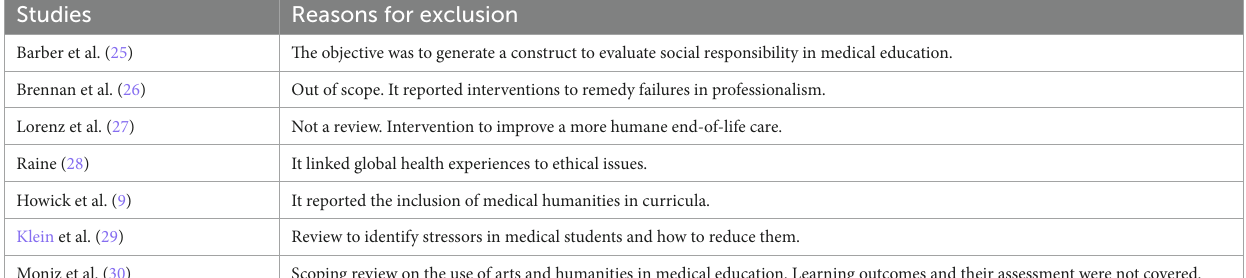
TABLE 4 Excluded potentially relevant studies (Spain, 2022).